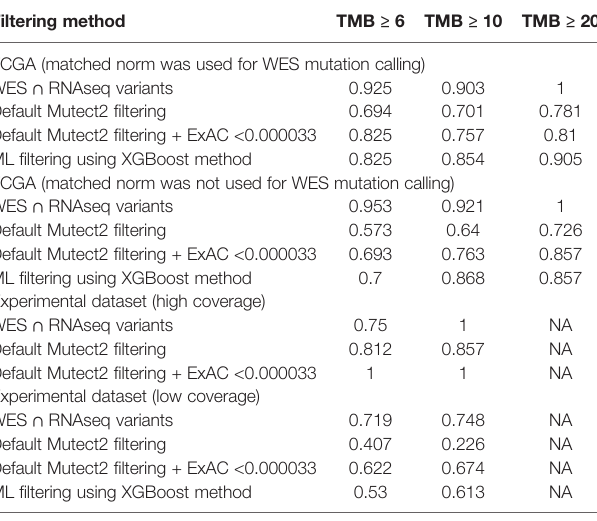
TABLE 1 | ROC AUC scores for predicting TMB ( ≥ 6, ≥ 10, and ≥ 20 thresholds) from FFPE RNAseq data, according to TMB-WES standards calculated with matched normal WES pro fi